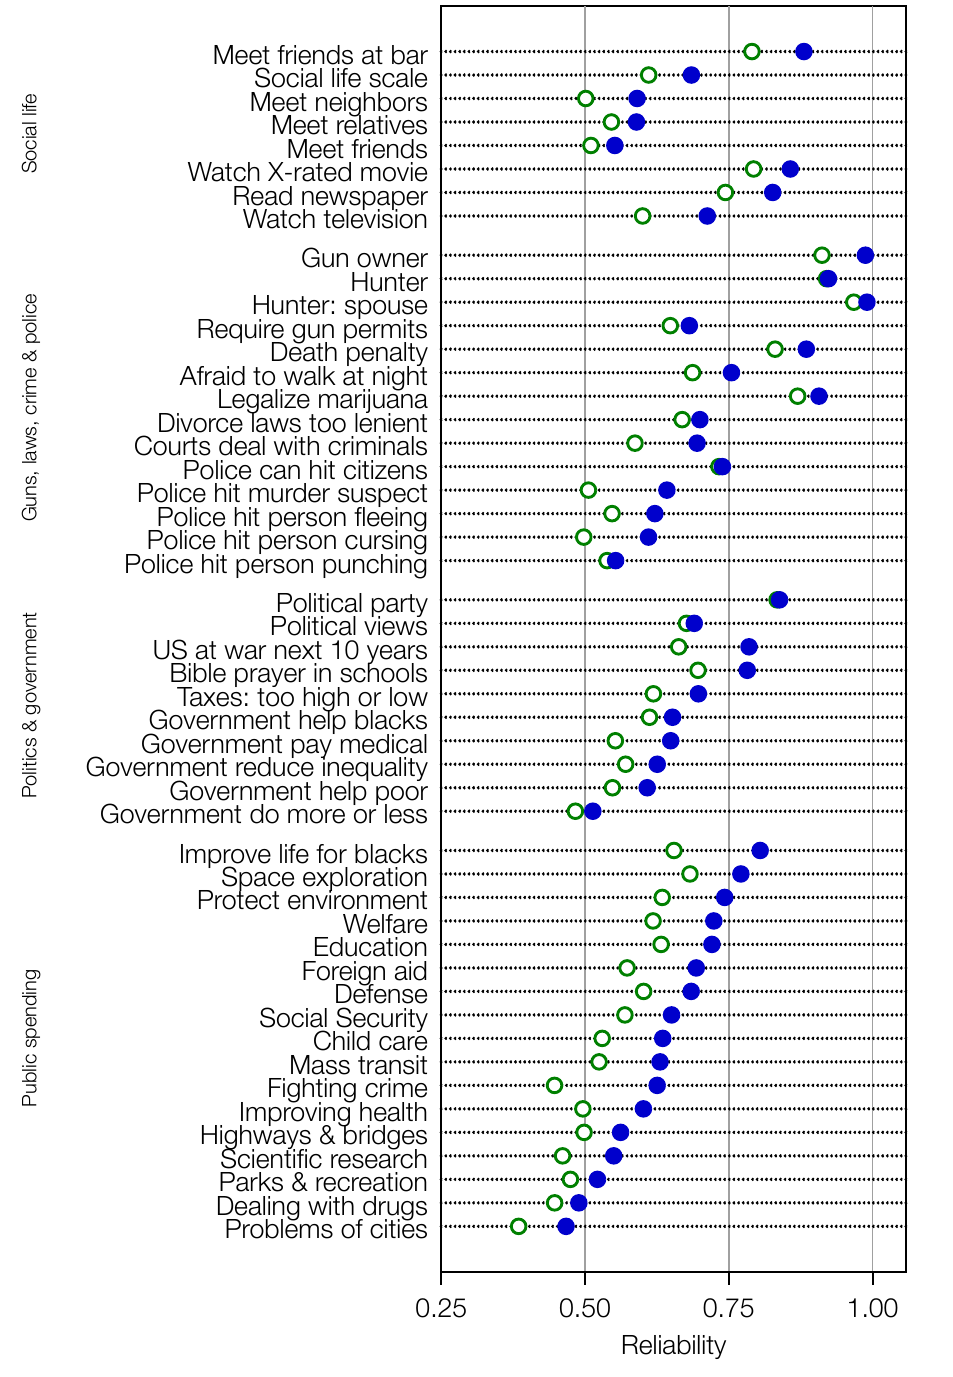
Figure 5: Reliability estimates for items about social life, politics, and government. Key: The estimates from the Alwin–Heise model are shown by solid blue circles; the estimates from our hierarchical linear models are in open green circles. The open green circle is not visible when the estimates are very close. Source: Authors’ calculations from the General Social Survey three-wave panels, 2006–2014. sociological science |